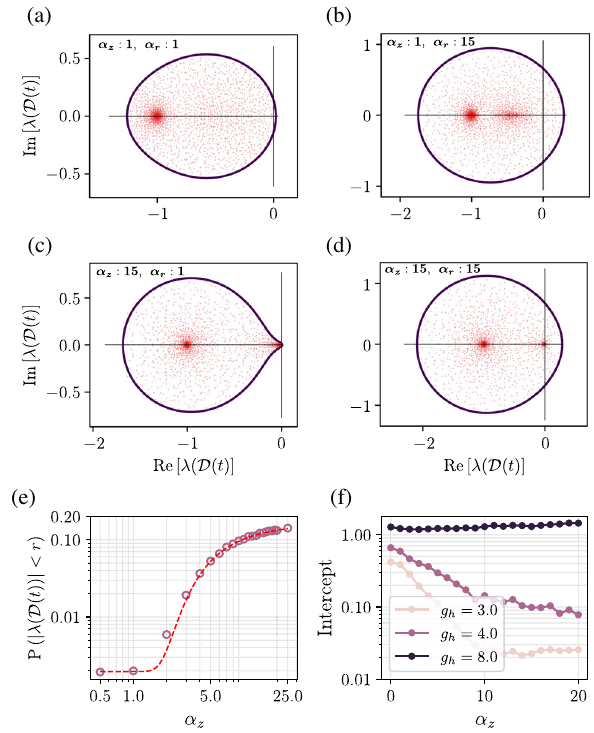
FIG. 1. How gates shape the Jacobian spectrum. (a) – (d) Jacobian eigenvalues (red dots) of the gated RNN in (time- varying) steady state. The dark outline is the spectral support curve predicted by Eq. (5). The bottom row corresponds to larger α , and the right column corresponds to large α . (e) Cumulative z r distribution function of Jacobian eigenvalues in a disk of radius r ¼ 0 . 05 centered at the origin plotted against α . Circles are z numerical density calculated from the true network Jacobian (averaged over ten instances), and the dashed line is a fit from Eq. (7). (f) Intercept of the spectral curve on the imaginary axis, α 0 Þ . For plotted against α for three different values of g z h ð r ¼ 3 , and τ τ 1 unless network simulations, N ¼ 2000 , g h ¼ r ¼ z ¼ otherwise stated, and all biases are